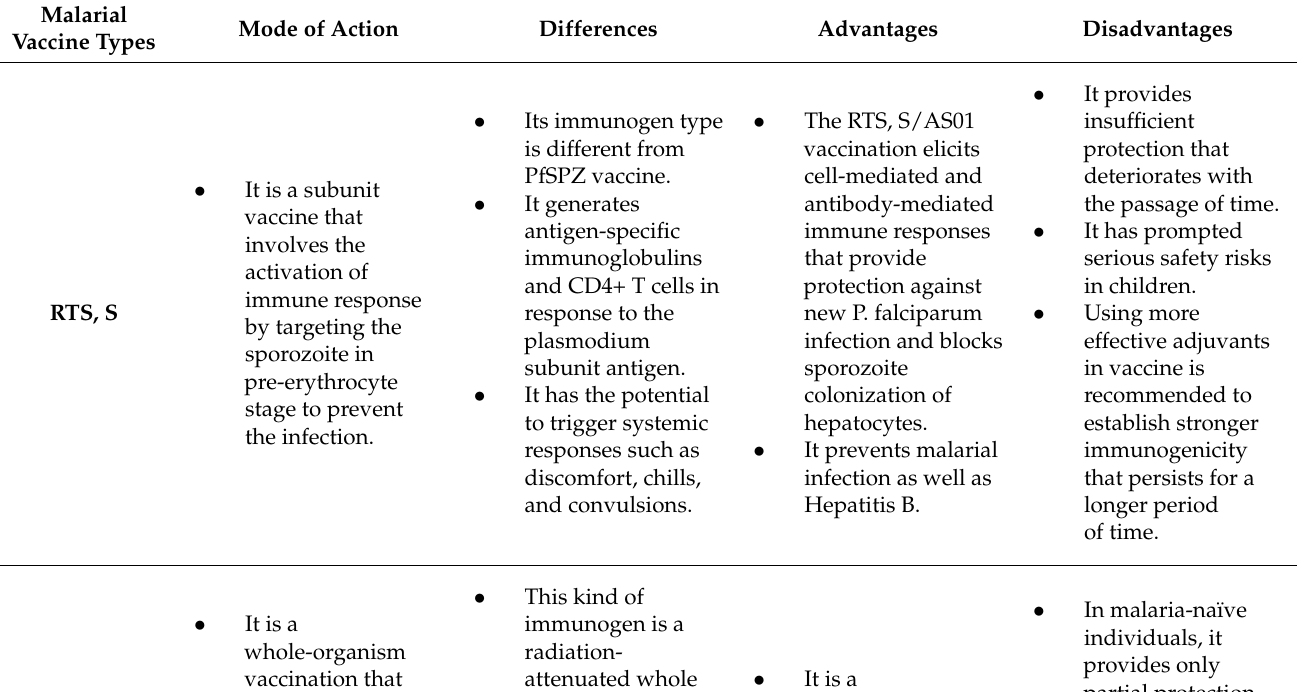
Table 2. Different kinds of malarial vaccines, along with their modes of action, potentials, and